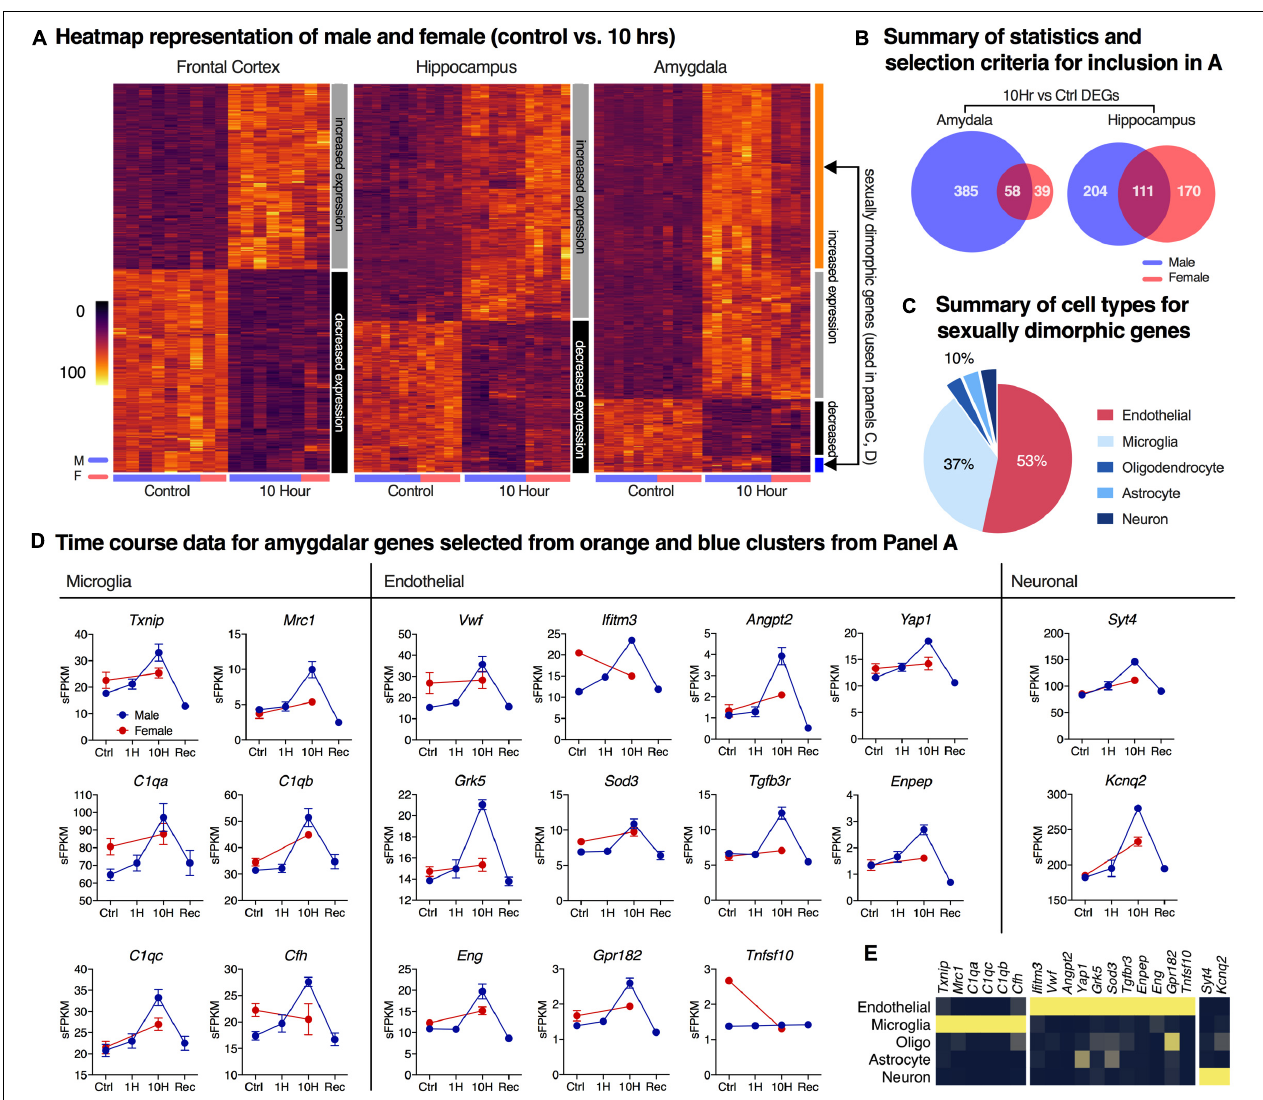
FIGURE 4 | Analysis of sexually dimorphic differentially expressed genes after ketamine infusion. Differentially expressed genes (DEGs) in control vs. 10-h groups in both male and female datasets were identified independently using pairwise comparisons in limma. (A) Hierarchical clustering was performed for genes that were differentially expressed at 10 h in at least one sex. The color bar to the right of each heatmap shows the clusters. DEGs show largely concordant induction (gray) or downregulation (black) between sexes in all brain regions. In the amygdala, two additional sexually dimorphic gene clusters were observed (orange, blue). (B) Non-concordant amygdaloid genes were categorized by cell type by referring to basal cell expression dataset from a previously published resource (Zhang et al., 2014). Cell type representation in the top 30 most non-concordant genes are shown, demonstrating large endothelial and microglial signatures. (C,D) Genes meeting discordance thresholds with high levels of specificity to cell type are shown (red = female, blue = male). (E) Expression data from Zhang et al. (2014) for endothelial cells, microglia, oligodendrocytes, astrocytes and neurons are shown for the selected genes in D, showing their high degree of enrichment in their respective cell types according to that dataset. The microglia genes mainly represent the complement cascade. The endothelial genes include a GPCR for the vasodilatory peptide adrenomedullin, a GPCR kinase, as well as genes in the TGF β family and others consistent with a complex network of endothelial regulation. Error bars show the standard error of the